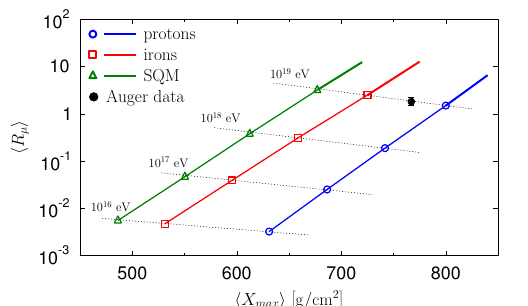
R µ of individual showers (cid:31) (cid:30)